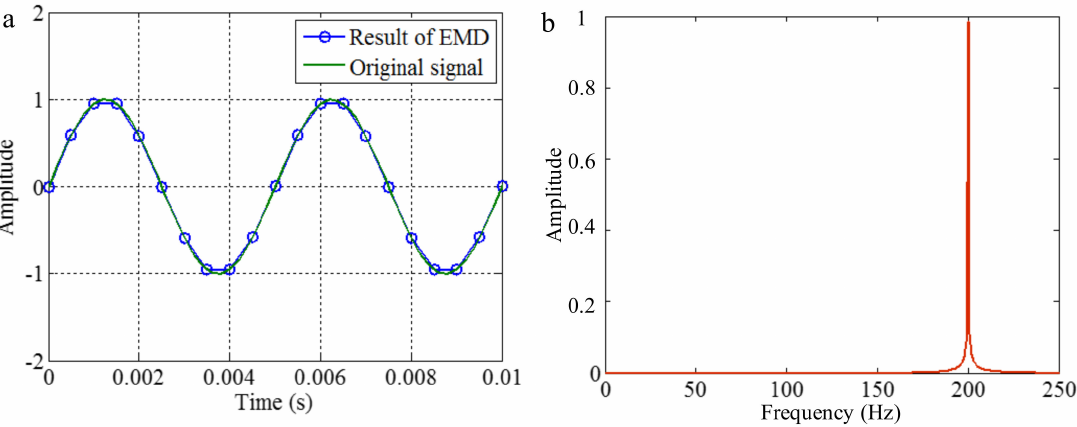
Figure 6. The EMD result of the signal of 200 Hz with a sampling frequency of 2 kHz and the corresponding Fourier spectrum: ( a ) the result of EMD and ( b ) the Fourier